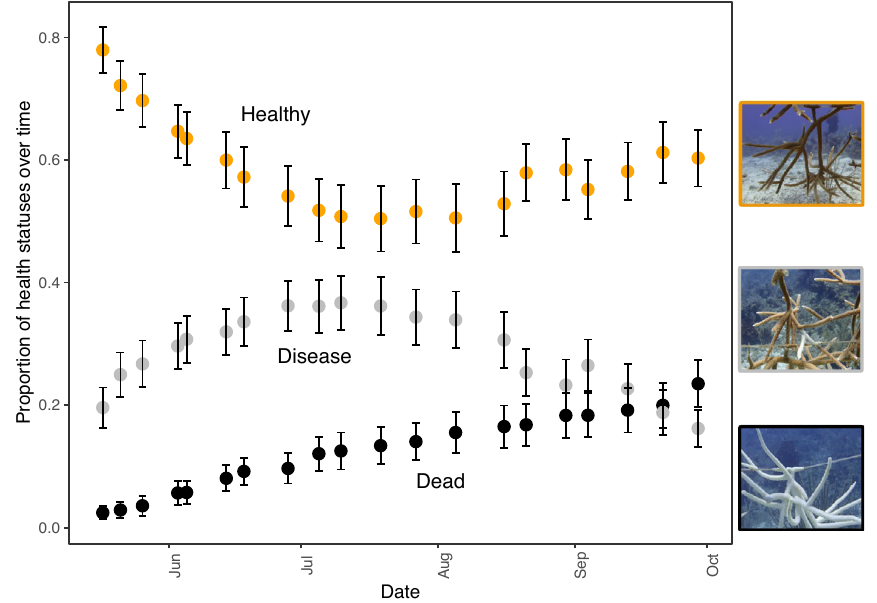
Figure 1. Mean ± standard error (SE) of the proportions of fragments in the nursery assigned to each health category over time. Images show the appearance of corals in each category, with healthy corals showing no apparent signs of disease (outlined in orange corresponding to the orange points); diseased corals showing sloughing of tissue and a bright white skeleton left behind the lesion (outlined in gray corresponding to the gray points); and dead corals showing bright white skeletons with no tissue present and growth of algal turf (outlined in black corresponding to the black